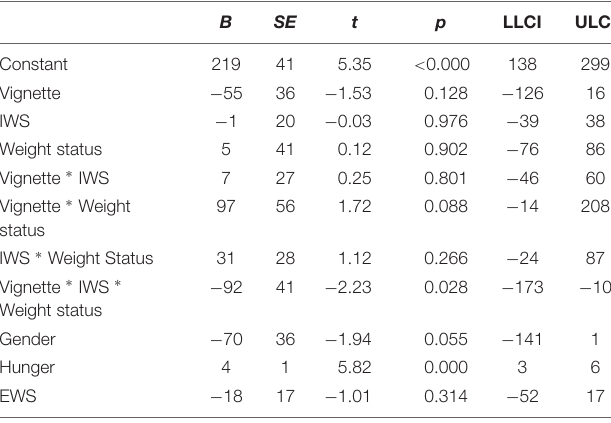
TABLE 1 | Effects of experimental condition, internalised weight stigma, and weight status on eating in the absence of